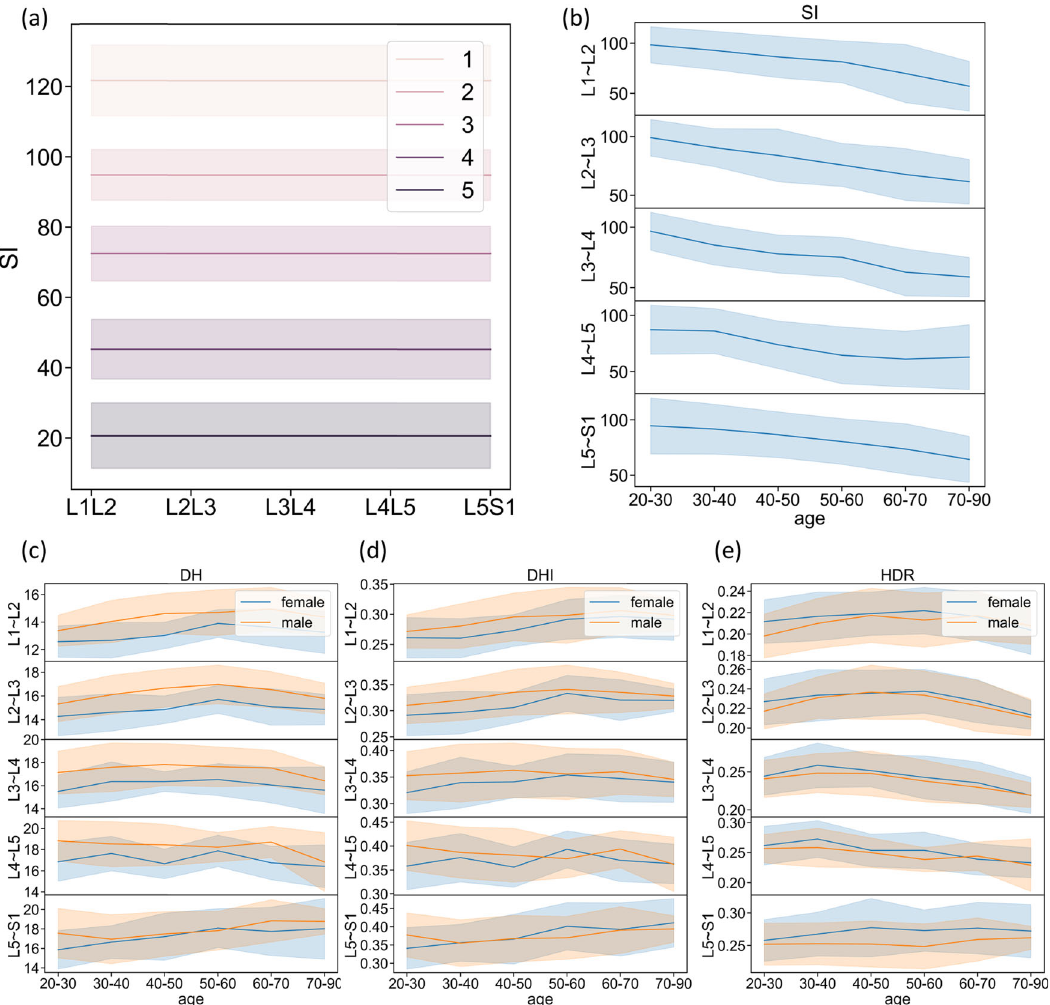
Fig. 3 Baseline characteristics of IVD parameters in geometric and signal intensity. The mean and standard deviation ( σ ) of the Δ SI of each of the modi fi ed P fi rrmann grading system (levels 1, 2, 3, 4, and 5) were calculated from Dataset C, which is used to quantify IVD degeneration ( a ), Δ SI ( b ), DH ( c ), DHI ( d ), and HDR ( e ) were quanti fi ed in different age, gender, and segments to establish population baseline.